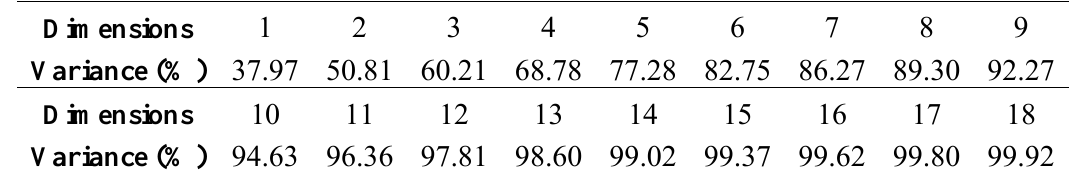
Table 3. Detailed data of PCA on 19 features.